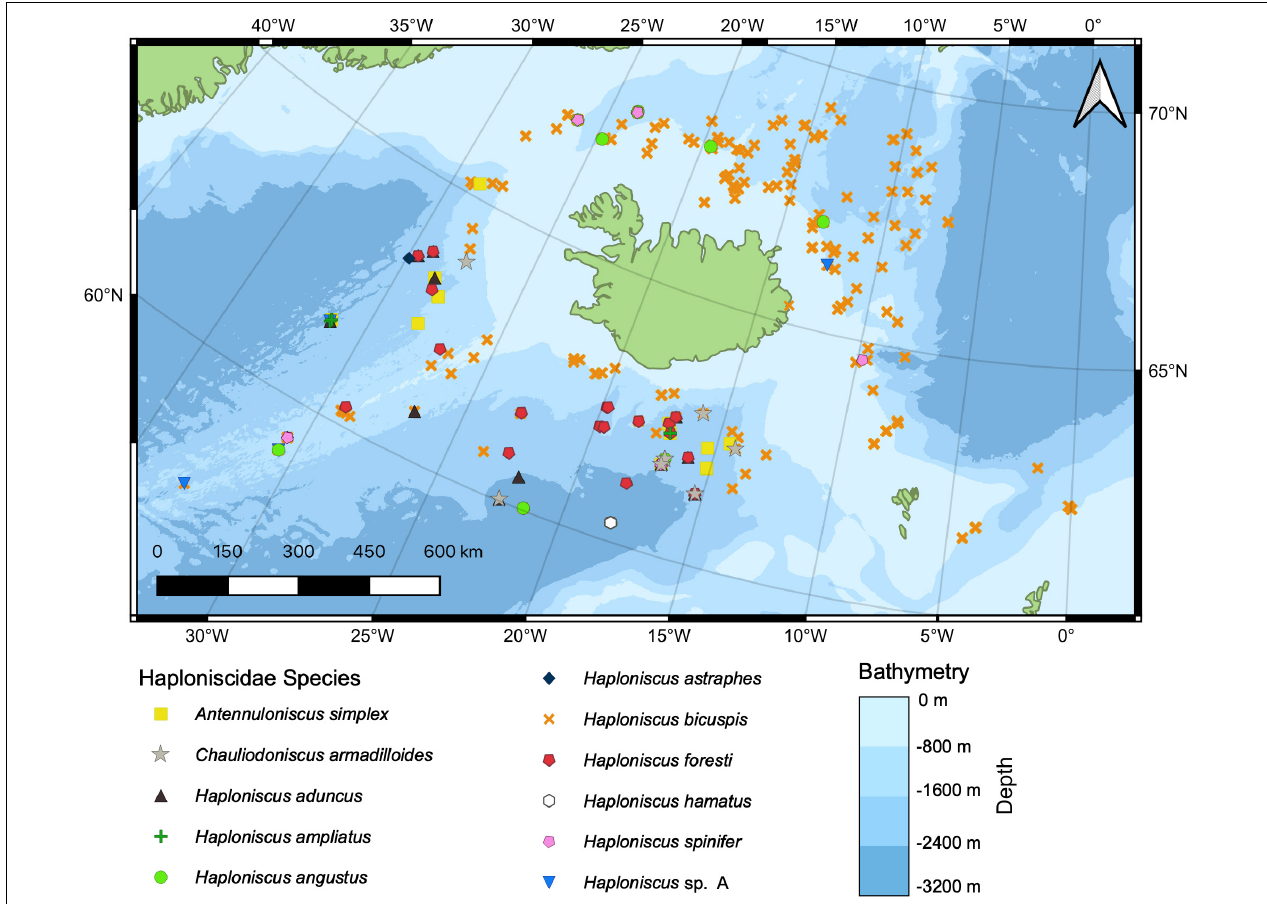
FIGURE 8 | Distribution of all Haploniscidae species found around Iceland collected during the BIOICE and IceAGE projects (Source for bathymetry: GEBCO Bathymetric Compilation Group, 2020).